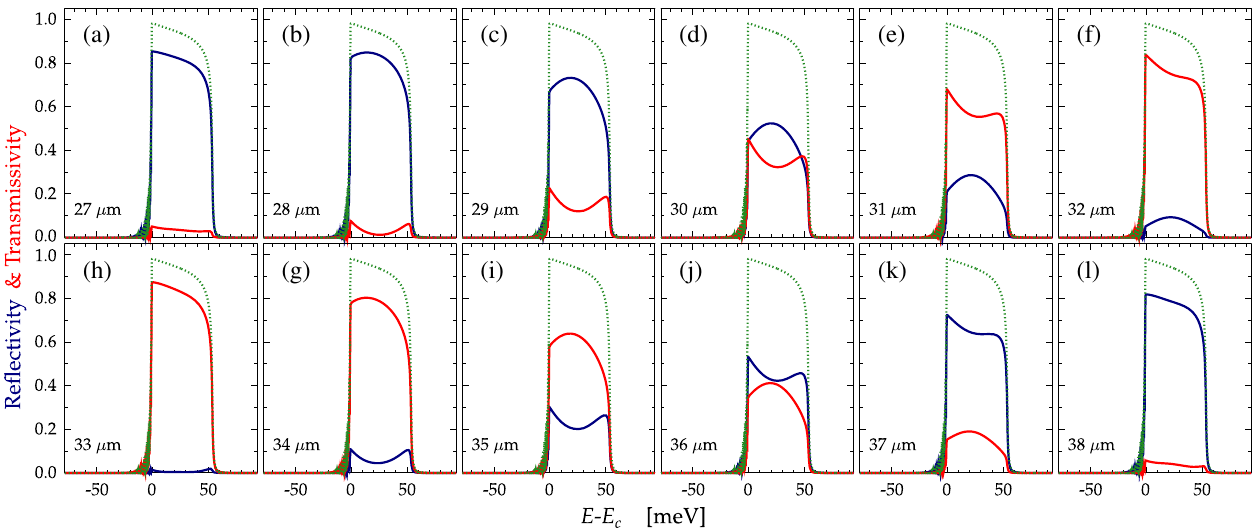
FIG. 7. Similar to Fig. 5; however, the beam-splitter crystal is in the transmission (Laue-case) geometry; see Fig. 3(b). The beam- splitter crystal thickness d varies from 27 μ m (a) to 38 μ m (l). Other parameters are provided in the caption to Fig. 6. Instead of varying the crystal thickness, azimuthal angle φ (see Fig. 6) can be varied alternatively by crystal rotation about the diffraction vector H in the range from about 0 to